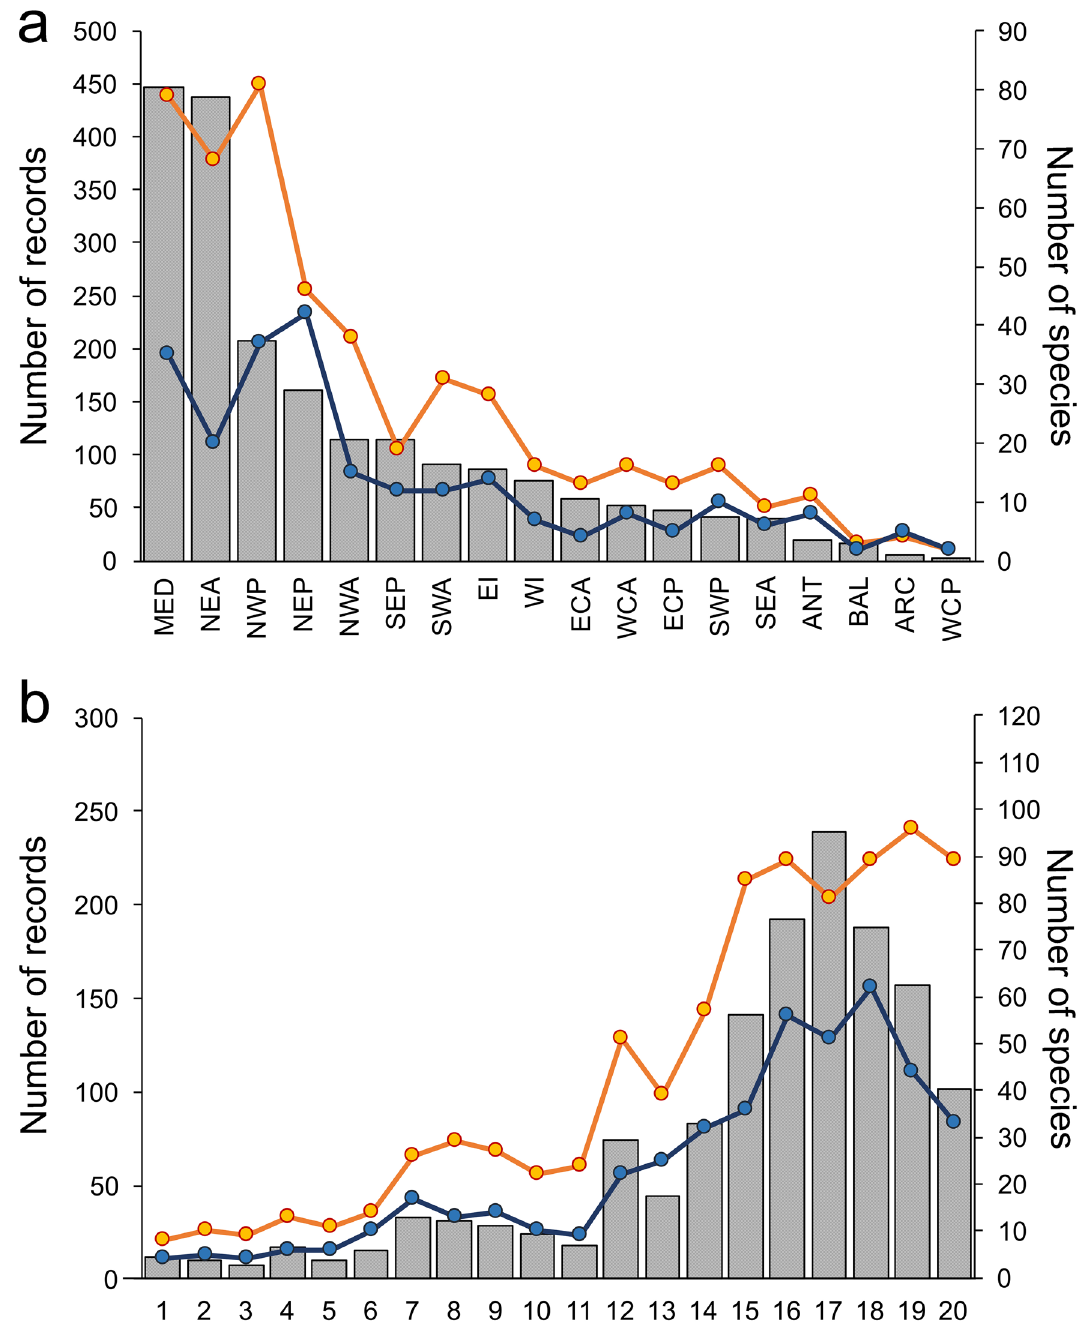
Figure 2. ( a ) Number of records of host-parasite associations (left y -axis) and number of parasite (orange line) and host (blue line) species (right y- axis) found in each geographic area (MED: Mediterranean Sea; NEA: NE Atlantic Ocean; NWP: NW Pacific Ocean; NEP: NE Pacific Ocean; NWA: NW Atlantic Ocean; SEP: SE Pacific Ocean; SWA: SW Atlantic Ocean; EI: Eastern Indian Ocean; WI: Western Indian Ocean; ECA: East Central Atlantic Ocean; WCA: West Central Atlantic Ocean; ECP: East Central Pacific Ocean; SWP: SW Pacific Ocean; SEA: SE Pacific Ocean; ANT: Southern Ocean; BAL: Baltic Sea; ARC: Arctic Ocean; WCP: West Central Pacific Ocean). ( b ) Number of records of host-parasite associations (left y -axis) and number of parasite (orange line) and host (blue line) species (right y- axis) found in each decade from 1817 until 2017. Numbers on the x -axis indicated the 20